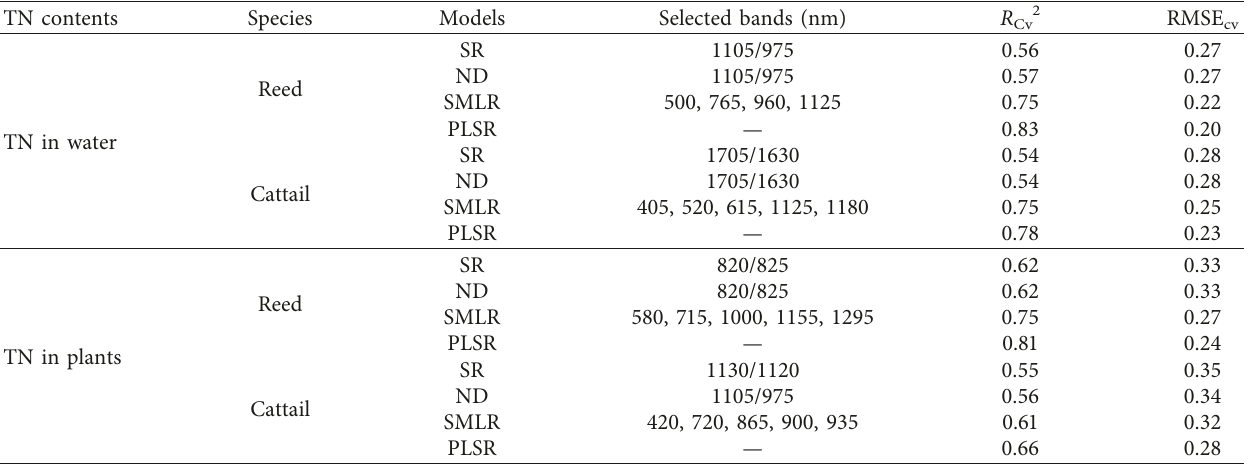
Table 2: Band position and performance of different models for predicting TN